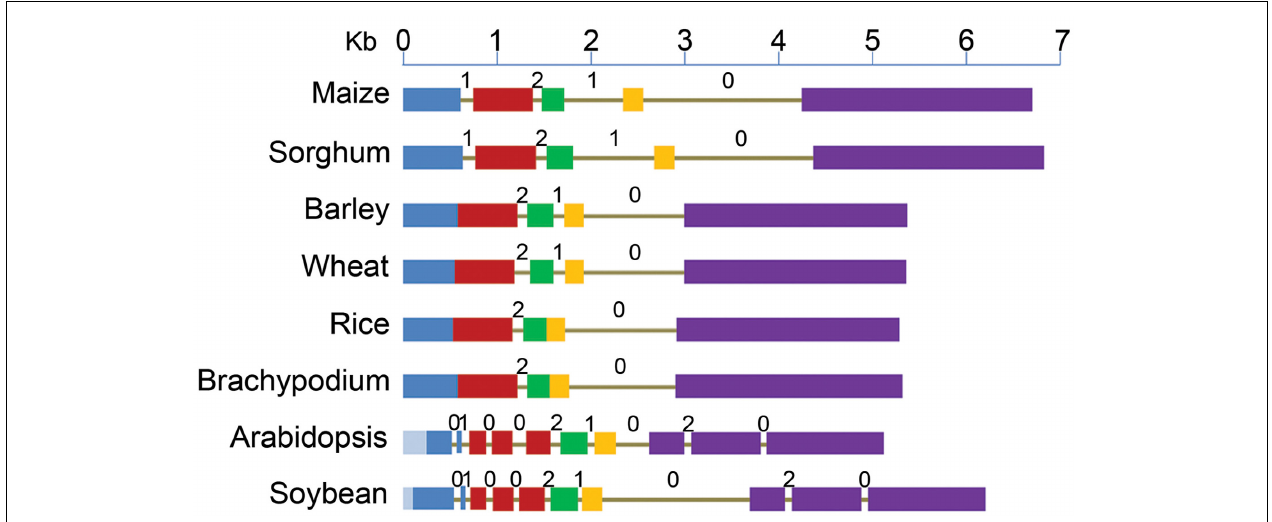
FIGURE 1 | Structure of ABCB1 genes starting from translation start to stop sites in six monocot and two dicot species. Drawn to scale, exons are represented by boxes and introns as lines. Each of the five exons of maize is